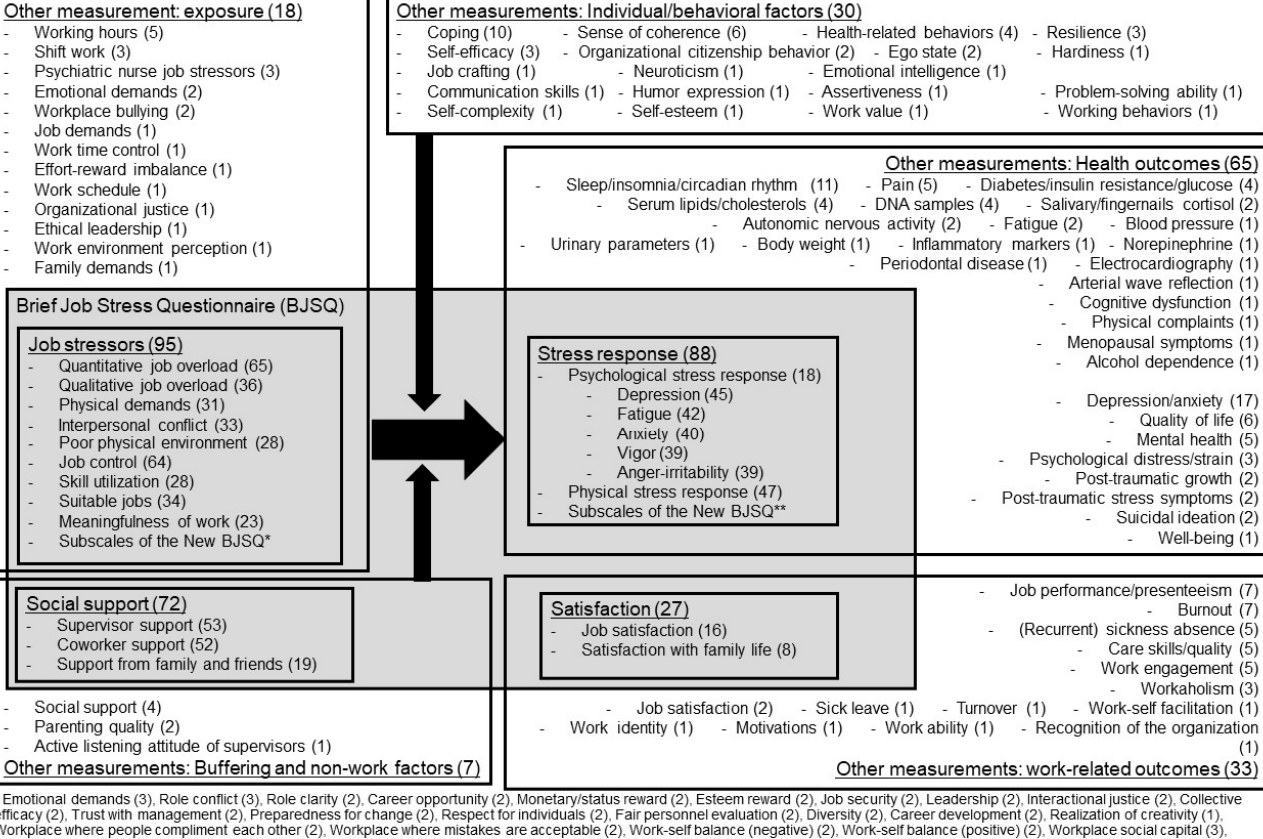
Figure 2. Used subscales from the BJSQ, the New BJSQ, and other measurements in the included studies. Note. Parenthesis in each subscale shows the number of times the measurements have been used.